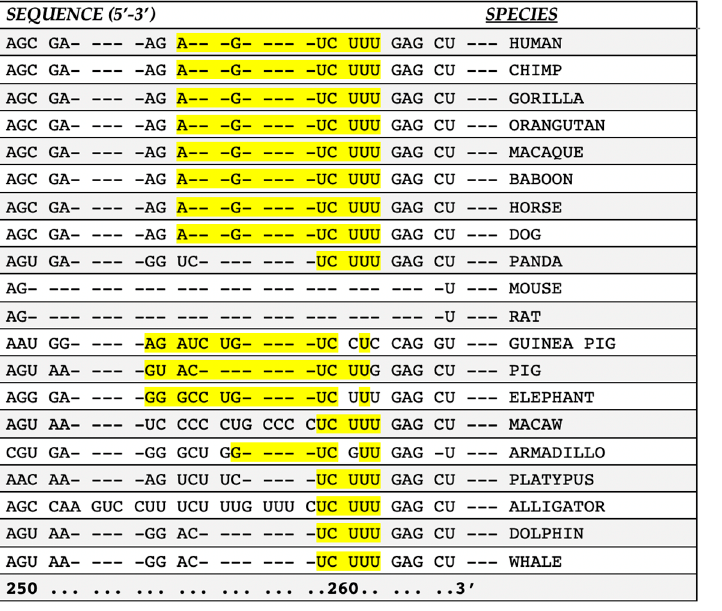
Figure 1. Identification of miR-4432 as a specific modulator of FGFBP1; the complementary nu- cleotides between the target region of FGFBP1 3 (cid:48) -UTR and hsa-miR-4432-3p, highlighted in yellow, are conserved across a number of different species, including